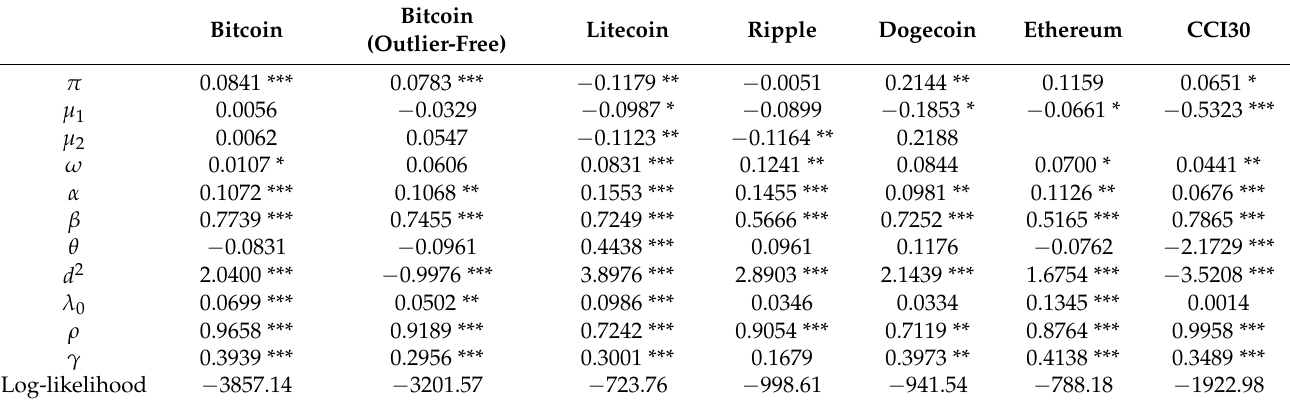
Table 2. Estimates of GARCH-jump